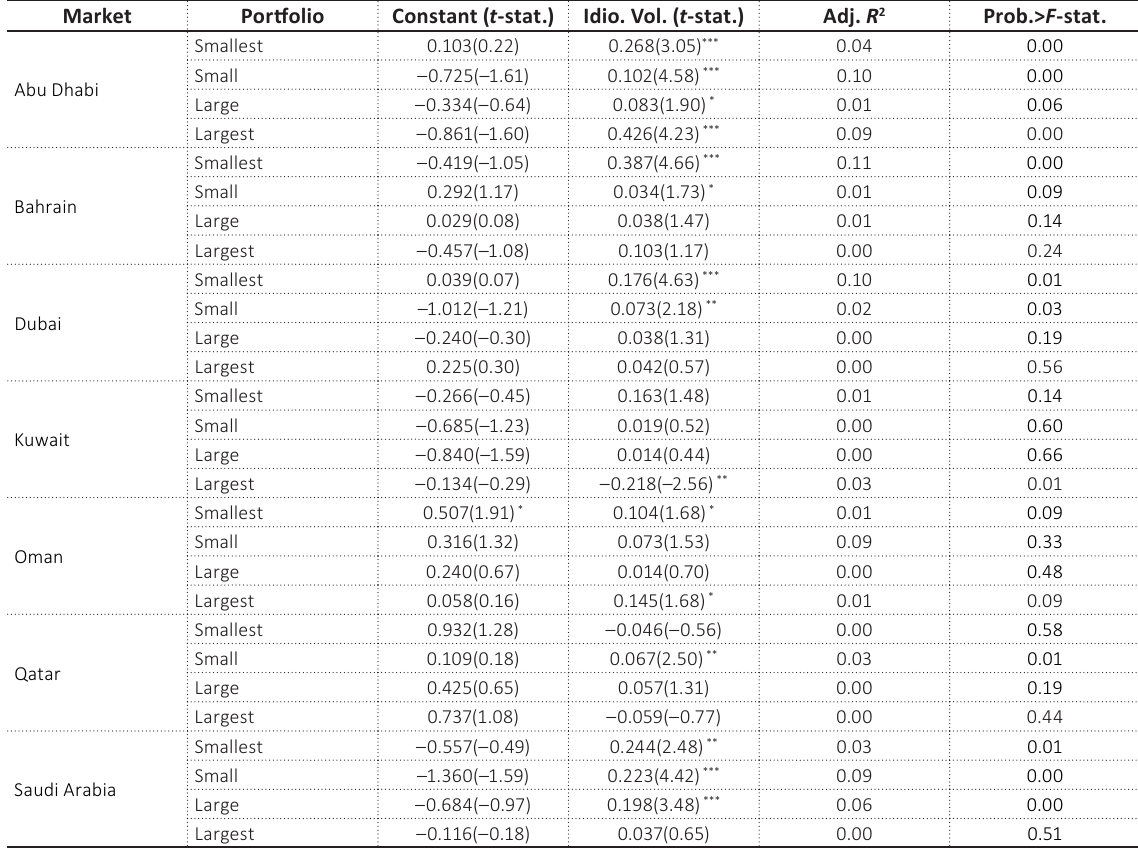
Table 2. Impact of idiosyncratic volatility on size-portfolio returns